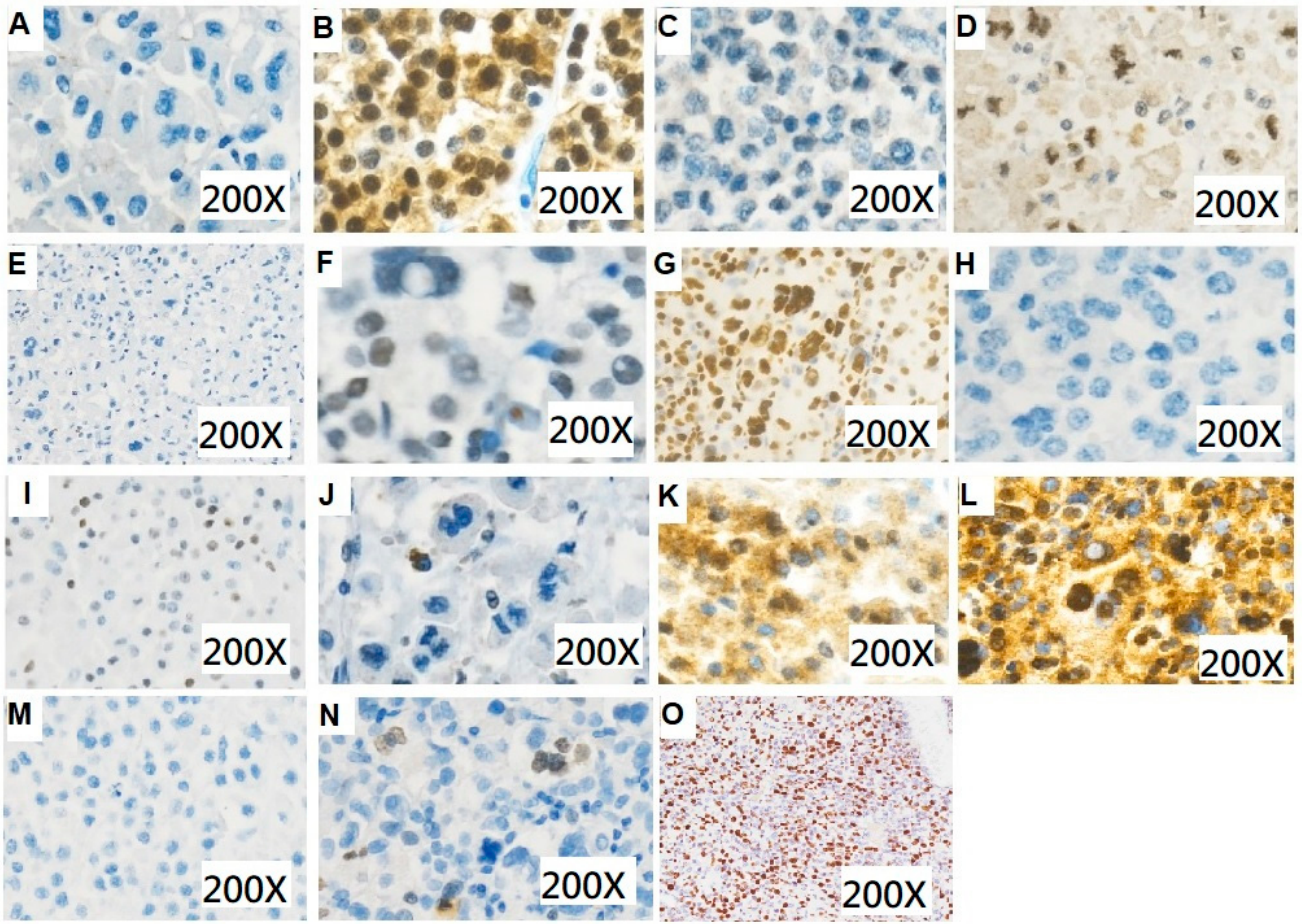
Figure 2. Immunohistochemical staining for patients with adrenocortical carcinoma. ( A ) Beta-catenin (200×): negative ( B ) Beta-catenin (200×): positive ( C ) CDK4 (200×): negative ( D ) CDK4 (200×): positive ( E ) ATRX (200×): negative ( F ) ATRX (200×): positive ( G ) P53 (200×): total positive ( H ) P53 (200×): total negative ( I ) P53 (200×): mosaic ( J ) SSTR2 (200×): low expression score ( K ) SSTR2 (200×): moderate expression score ( L ) SSTR2 (200×): high expression score ( M ) Ki-67 (200×): low expression ( N ) Ki-67 (200×): moderate expression ( O ) Ki-67 (200×): high expression. Table 1. Clinical presentation of 14 patients with ACC.